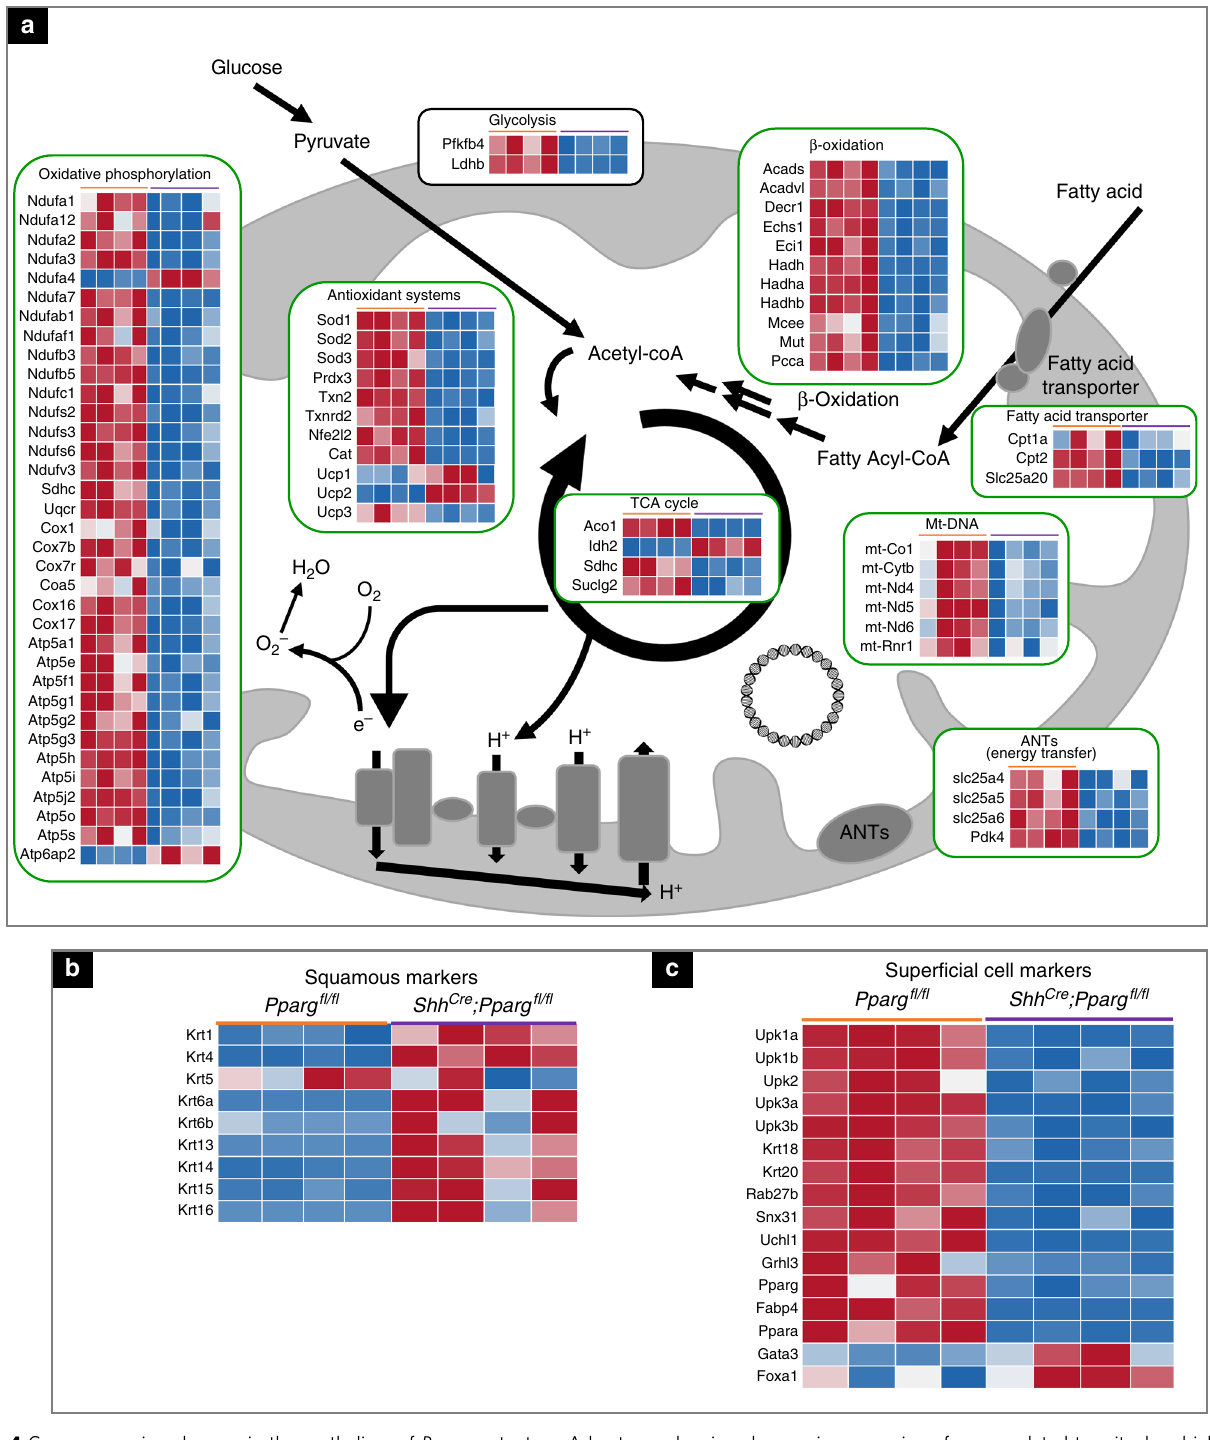
Fig. 4 Gene expression changes in the urothelium of Pparg mutants. a A heatmap showing changes in expression of genes related to mitochondrial functions in Shh Cre ;Pparg fl / fl mutants compared to controls. b A heatmap showing squamous markers that are up-regulated in Shh Cre ;Pparg fl / fl mutants. c A heatmap showing changes in expression of S cell markers in Shh Cre ;Pparg fl / fl mutants compared to controls. P values for gene expression changes are listed in Supplementary Table 1. RNA-Seq analysis was performed on RNA isolated from four Shh Cre ;Pparg fl / fl mutants and four Pparg fl / fl